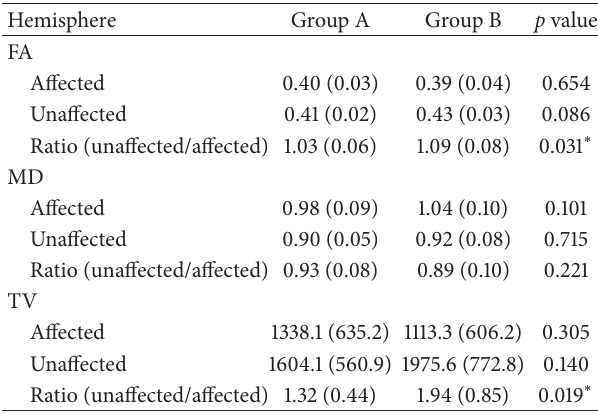
Table 2: Results of diffusion tensor imaging parameters of the connectivity of the red nucleus.